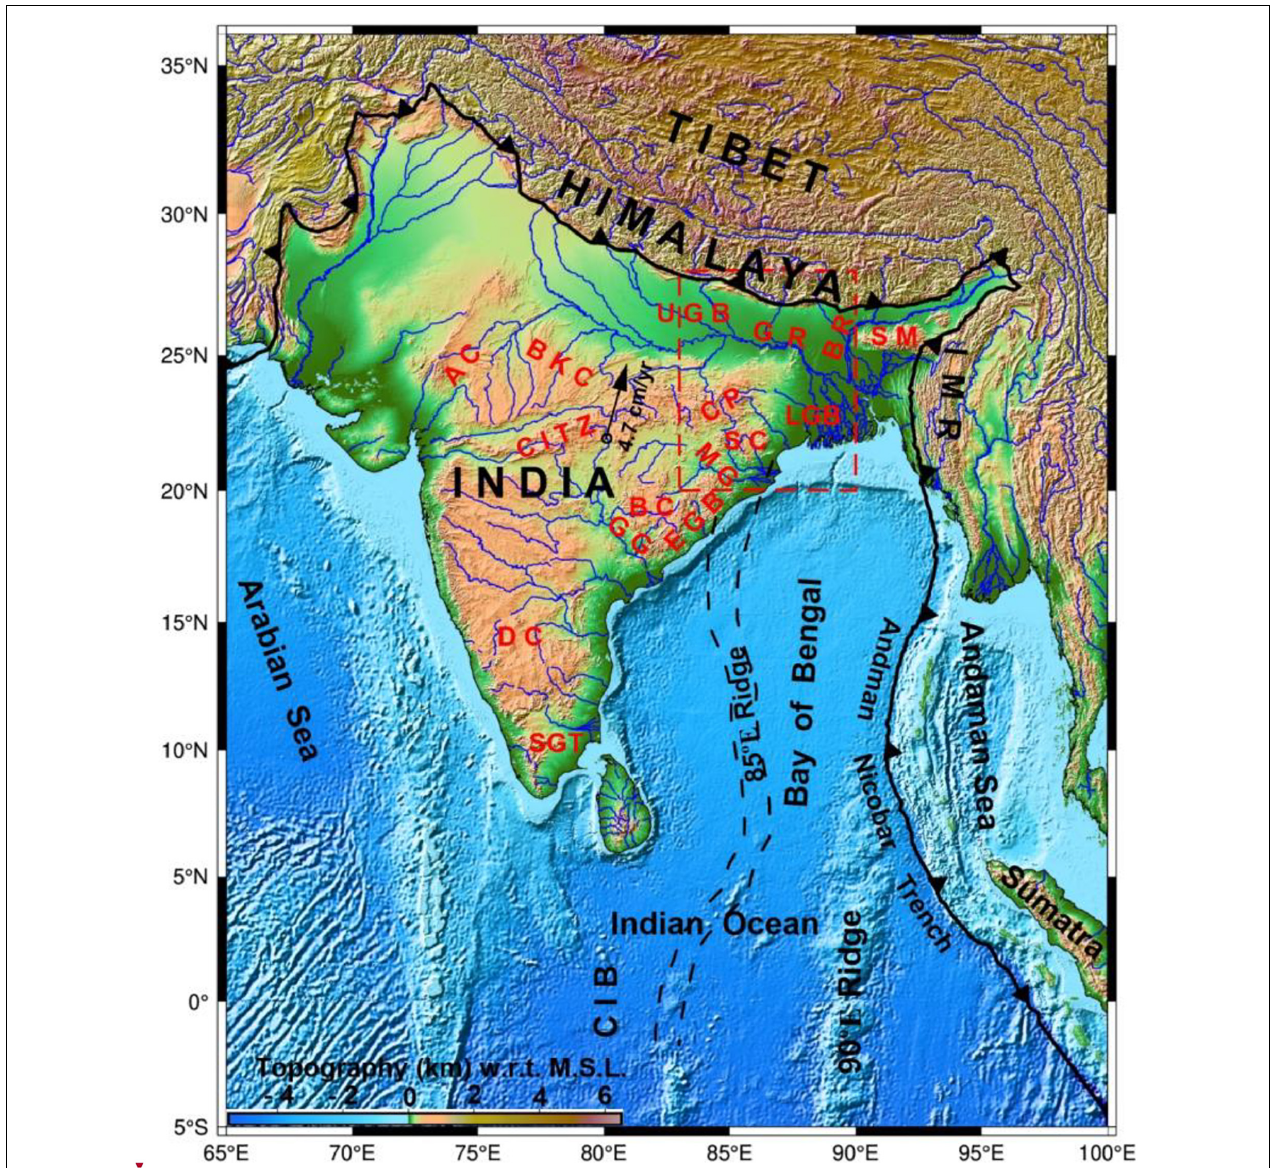
FIGURE 1 | Regional map (reconstructed after Khan et al., 2017b; Valdiya and Sanwal, 2017; Altenbernd et al., 2020) showing the location of the study area (rectangular block demarcated by red dashed line). Abbreviations: AC, Aravalli Craton; BKC, Bundelkhand Craton; CITZ, Central India Tectonic Zone; EGB, Eastern Ghats Belt; CP, Chhotanagpur Plateau; SC, Singhbhum Craton, BC, Bastar Craton; DC, Dharwar Craton; SGT, Southern Granulite Terrain; MG, Mahanadi Graben; GG, Godavari Graben; SM, Shillong Massif; IMR, Indo-Myanmar Range; GR, Ganga River; UGB, Upper Gangetic Basin; LGB, Lower Gangetic Basin; BR, Brahmaputra